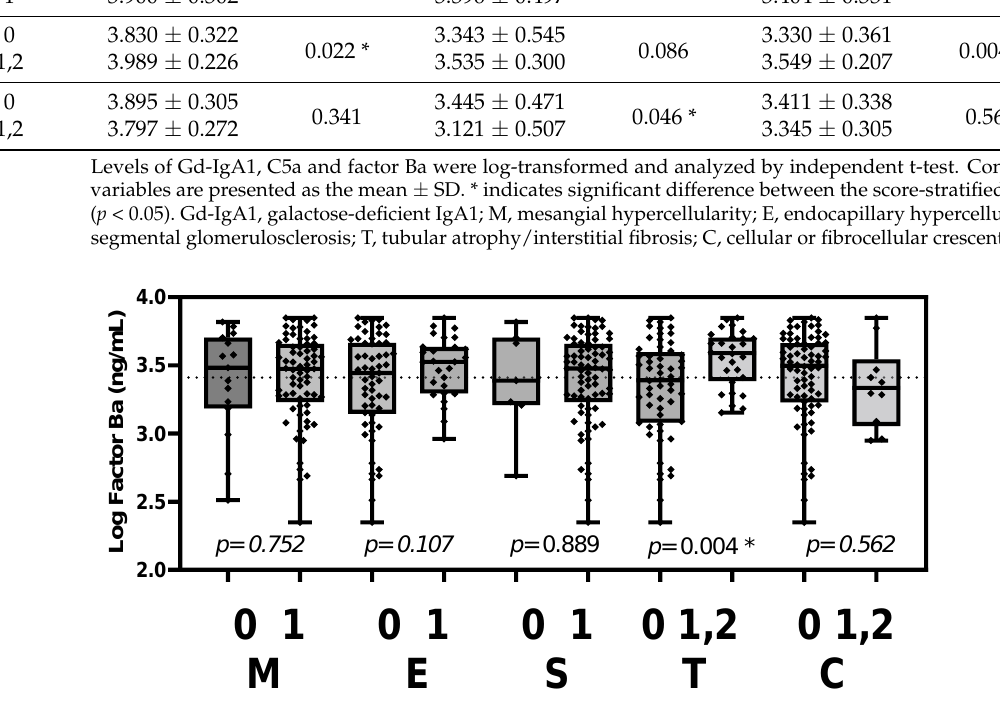
Figure 4. Plasma factor Ba levels stratified according to the Oxford MEST-C criteria. Plasma factor Ba level was significantly elevated in patients with tubular atrophy/interstitial fibrosis ( p = 0.004). M, mesangial hypercellularity; E, endocapillary hypercellularity; S, segmental glomerulosclerosis; T, tubular atrophy/interstitial fibrosis; C, cellular or fibrocellular crescents. * p < 0.05.